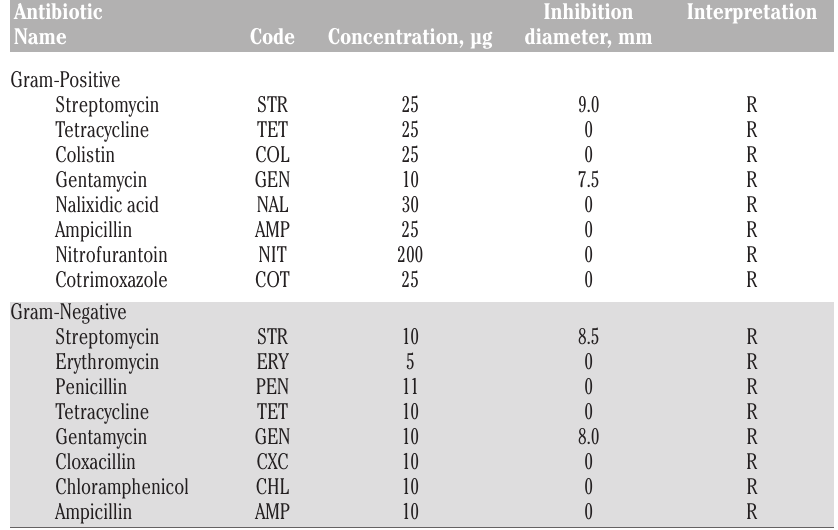
Table 1. Antibiotic susceptibility profile of E. coli isolated from Staff Club swimming